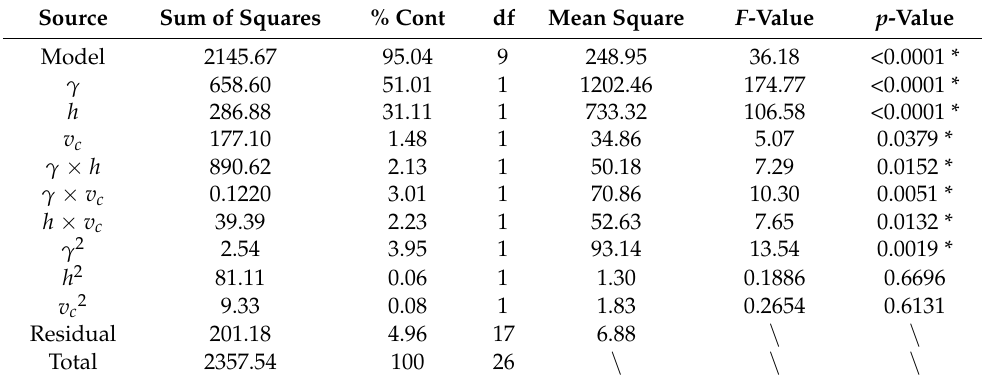
Table 6. Variance analysis of resultant force.